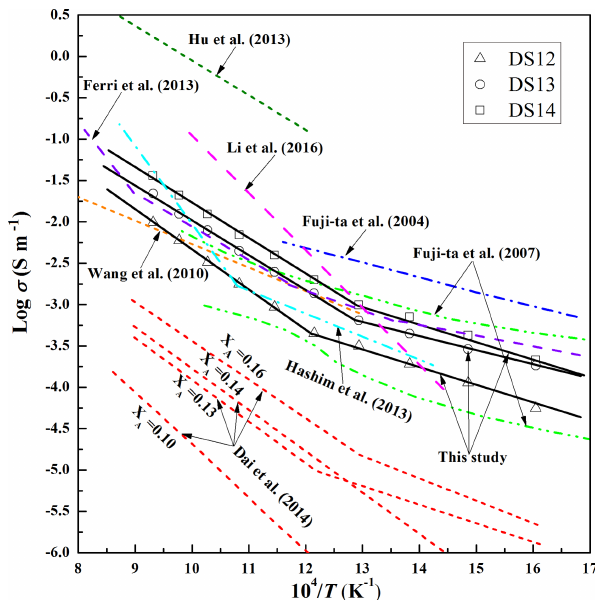
Figure 8. Comparisons of the electrical conductivities of the gneiss samples measured at 1.5GPa in this study and in previous studies. The dashed blue and green lines represent the electrical conductiv- ities of granulite and gneiss at 1.0GPa from Fuji-ta et al. (2004, 2007), respectively. The dashed orange line represents the electri- cal conductivity of quartz at 1.0GPa from Wang et al. (2010), and the dashed dark green line represents the electrical conductivity of alkali feldspars at 1.0GPa from Hu et al. (2013). The dashed sky blue line represents the electrical conductivity of natural PP216 metapelite at 0.3GPa from Hashim et al. (2013), and the dashed vi- olet line represents the electrical conductivity of the residual JOY2- X4 enclave at 0.3GPa from Ferri et al. (2013). The dashed red lines represent the electrical conductivity of granite at 0.5GPa from Dai et al. (2014), and the dashed pink line represents the electrical con- ductivity of phlogopite at 1.0GPa from Li et al.